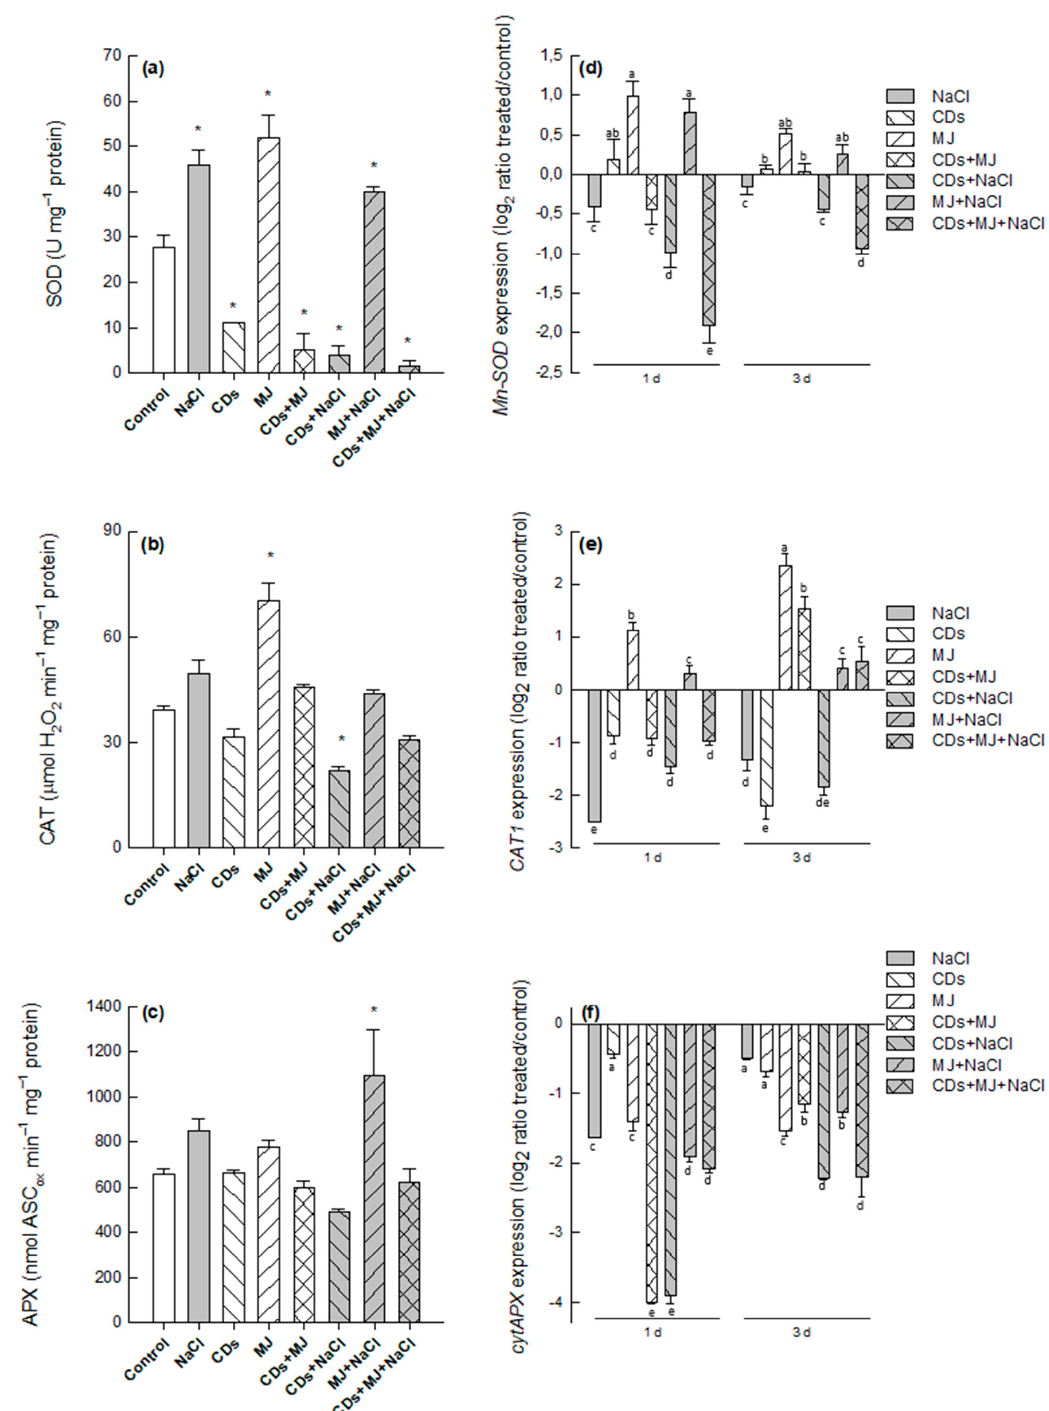
Figure 5. The effects of salt and/or elicitor treatments on the specific enzymatic activity of SOD ( a ), CAT ( b ), and APX ( c ) and the gene expression of Mn-SOD ( d ), CAT1 ( e ), and cyt APX ( f ), analyzed by qRT-PCR. The data represent the mean ± SE of three independent replicates. Enzymatic values marked with an asterisk are significantly different from control ( p < 0.05) by Tukey’s HSD test. Gene expression values followed by different letters are significantly different at p < 0.05 by Tukey’s HSD test.